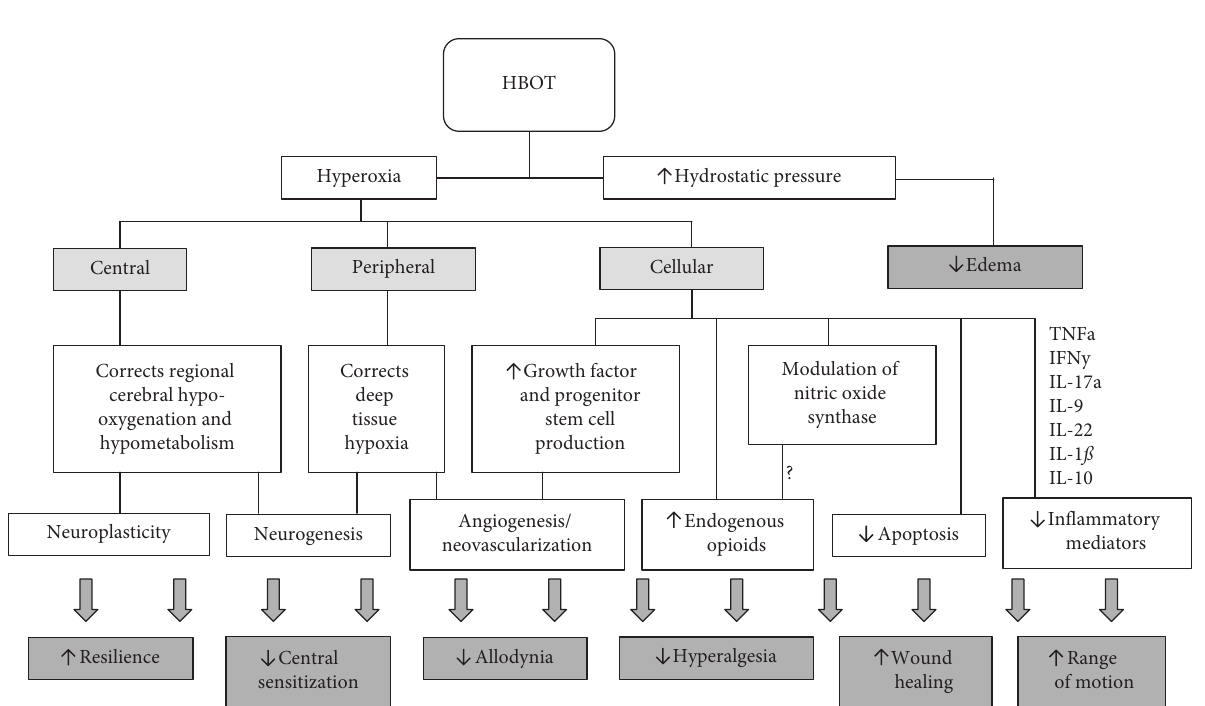
Table 4: Side effects of hyperbaric oxygen therapy [10].